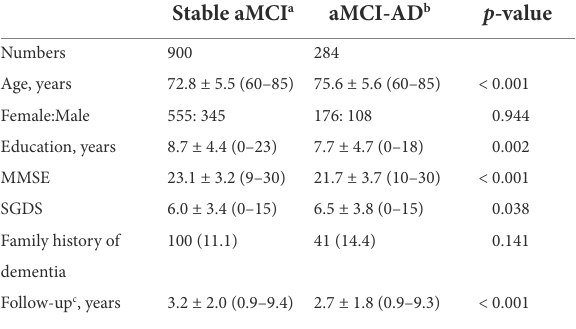
TABLE 2 Demographic and clinical characteristics of the study participants classified according to whether they progressed to Alzheimer’s